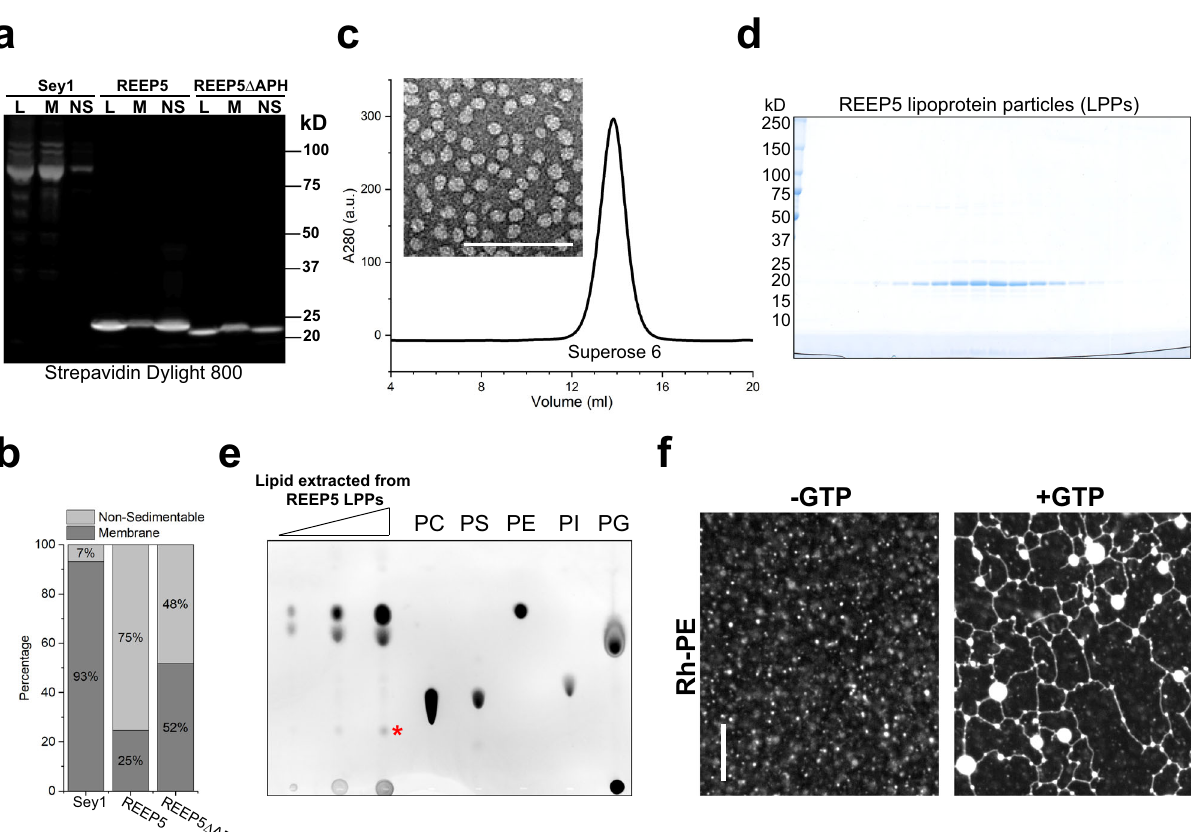
Fig. 4 Overexpression of REEP/Yop1 in E. coli generates lipoprotein particles (LPPs). a SBP-tagged REEP5, REEP5 Δ APH, or Sey1 were expressed in E. coli . Lysates (L) were fractionated by centrifugation into a non-sedimentable fraction (NS) and membrane fraction (M). Equivalent aliquots of these fractions were analyzed by SDS-PAGE, followed by blotting with Dylight 800-labeled streptavidin. b Quanti fi cation of the data in a . The experiment was performed two times. c Xenopus REEP5 was expressed in E. coli and puri fi ed from the NS fraction. It was then subjected to size-exclusion chromatography (SEC) and its elution followed by the absorbance at 280 nm. The inset shows a representative negative-stain image of the peak fraction. The visualized structures are referred to as lipoprotein particles (LPPs). Bar, 100 nm. d Fractions of the SEC run in c were analyzed by SDS-PAGE and Coomassie-blue staining. The experiment was performed four times. e Lipids were extracted from the puri fi ed LPPs, and different amounts of the extract were analyzed by thin-layer chromatography (TLC) and Primuline-staining. Pure PC, PS, PE, PI, and PG were run in parallel as markers. The asterisk indicates an unidenti fi ed lipid. The experiment was performed two times. f Puri fi ed LPPs were co-reconstituted with the GTPase Sey1 into liposomes containing POPC, DOPE, DOPS, and fl uorescent rhodamine-PE (Rh-PE). The samples were incubated with or without GTP and visualized with a fl uorescence microscope. The experiment was performed two times. Bar, 10 µ